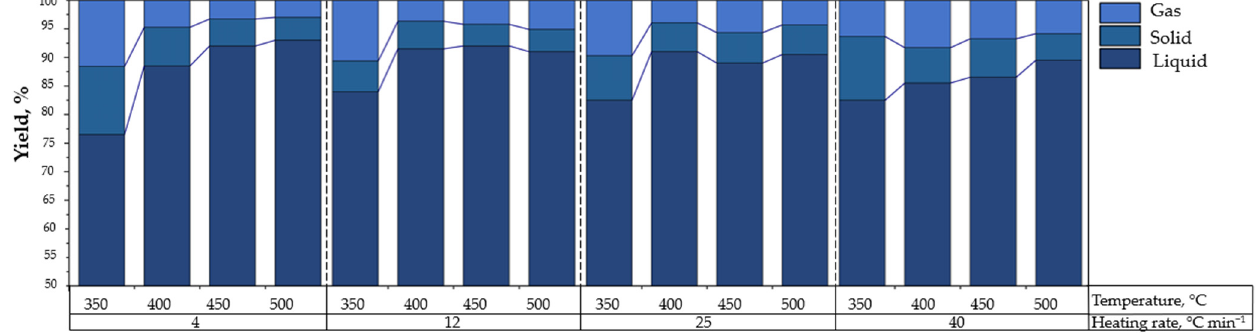
Figure 3. Influence of heating rate on EPS performance.